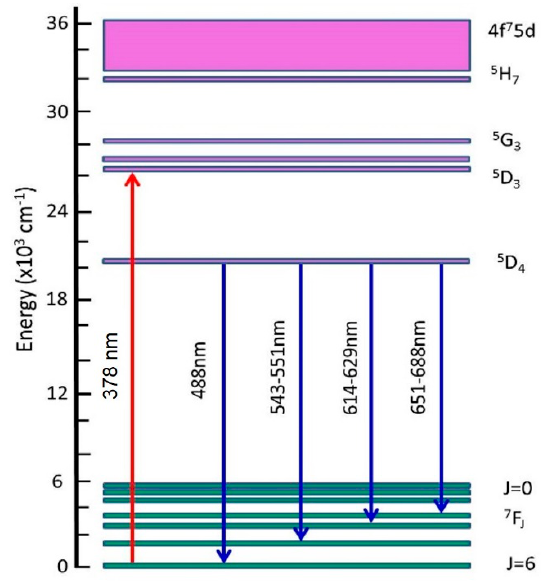
Figure 3. Energy level diagram for Tb 3 + .